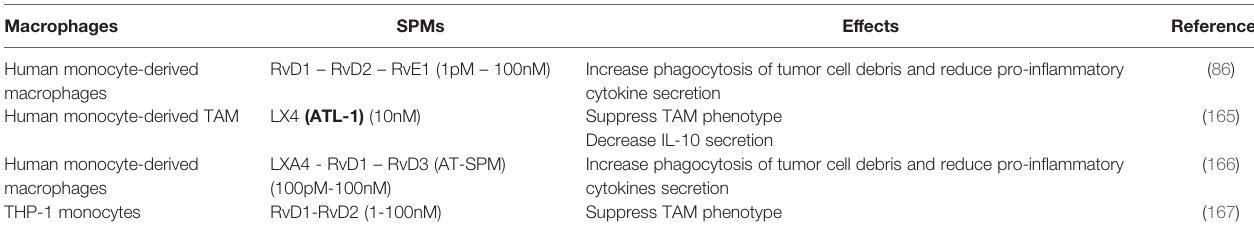
TABLE 2 | SPMs ’ effects on human macrophages in a cancer context.